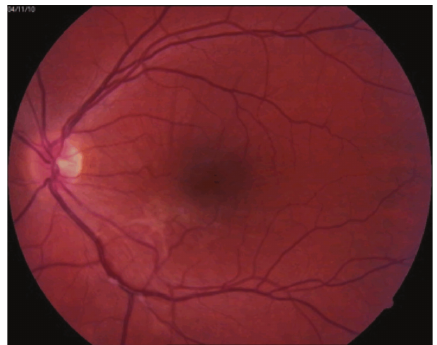
Figure 1: Color fundus photograph of the left eye. The macular region shows macular folds and distortion of the normal architecture of the juxtafoveal vessels. Being nasal and inferior to the fovea, there is evidence of an epiretinal fibrous tissue, which is likely due to the presence of an epiretinal membrane.